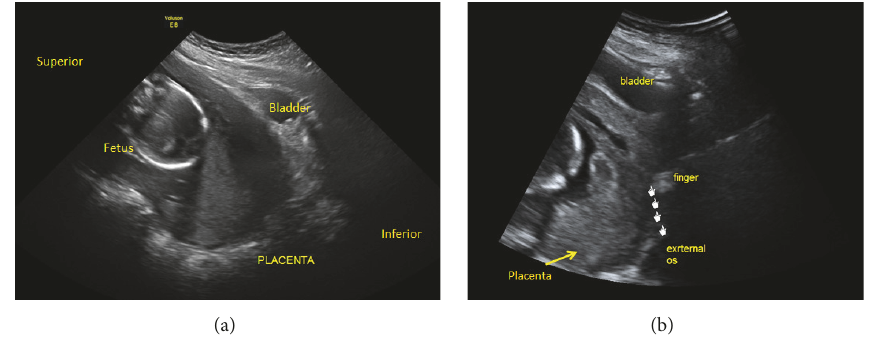
Figure 1: Transabdominal sagittal ultrasound image at 19 weeks showing complete placenta previa (a). Pelvic exam was unable to identify the cervix (b).